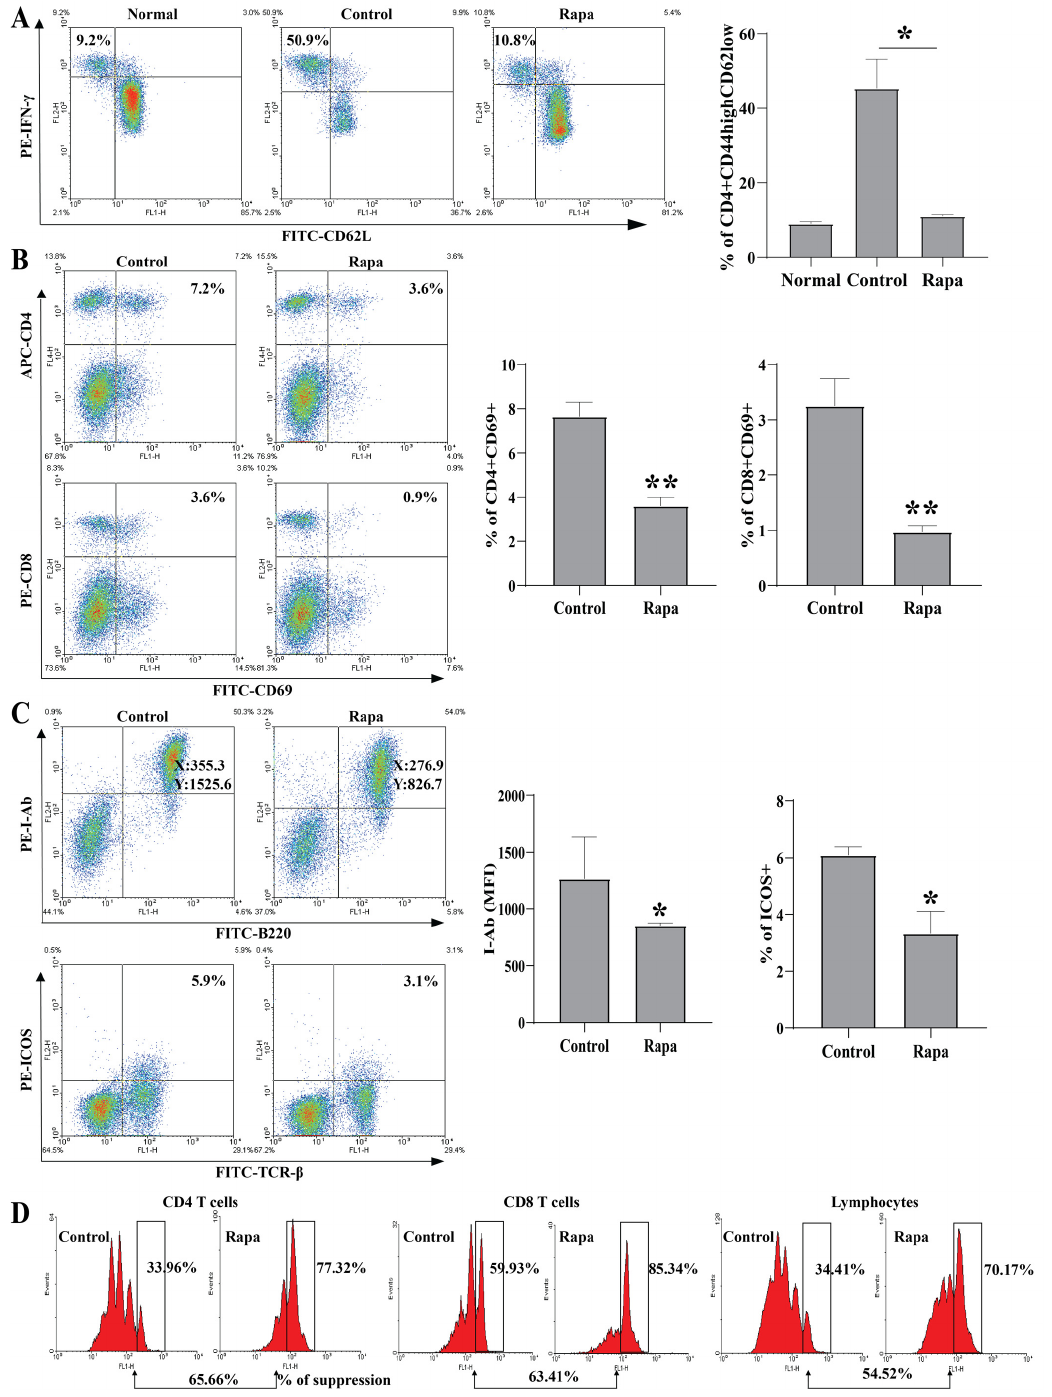
Figure 4. Rapamycin treatment inhibited lymphocyte activation and proliferation. ( A ) Flow analysis of CD4+CD44high CD62low population in periheral blood of the normal mice and the experimental mice ( n = 3 per group, * p < 0.05). The expression of CD69 ( B ) and ICOS ( C ) on splenic T cells, and the mean fluorescence intensity (MFI) of I-Ab expression ( C ) on splenic B cells was examined by flow analysis ( n = 3 per group, ** p < 0.01). ( D ) The CFSE-labeled peripheral blood lymphocytes of the experimental mice were stimulated with anti-CD3 mAb and anti-CD28 mAb for 72 h in vitro. The percentage of undivided cells in CD4 T cells, CD8 T cells and total lymphocytes was determined by flow analysis. The calculation of suppression rate was described in Section 2.9. Data are representative of at least three independent